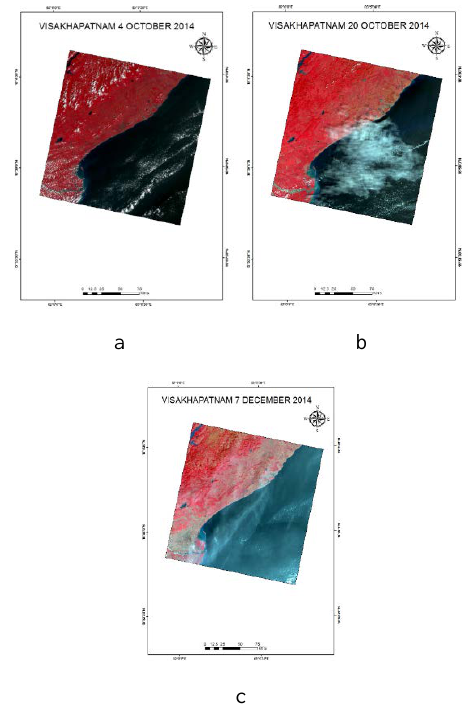
Figure 4. (a) Base map for before cyclone 4 Oct 14 (b) Base map for after cyclone 20 Dec 14 (c) Base map for after a month of cyclone 7 Dec